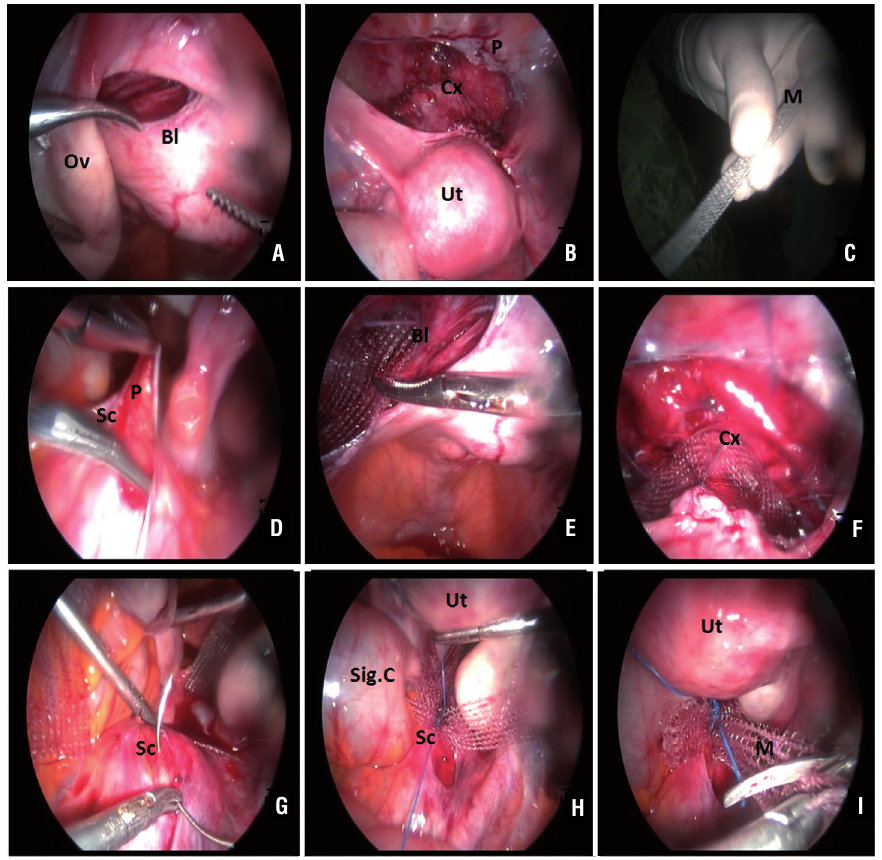
Figure 1 - The surgical procedure of Cravat technique. A) Opening of left broad ligament. B) Incision of vesicouterine peritoneum. C) 25x1.5 cm 2 prolene mesh. D) Opening of peritoneum over the sacral promontorium. E) Mesh inserted to the windows in broad ligaments. F) Suturing of the mesh over the anterior cervix. G,H) Suturing of the mesh over the sacral promontory. I) Trimming of the rest of the